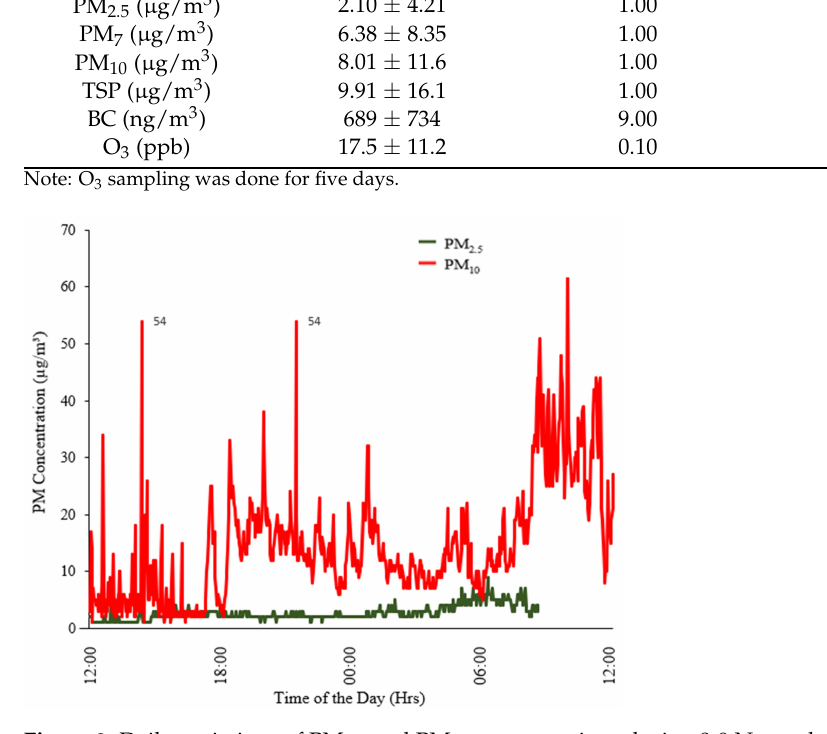
Table 1. Summary statistics of daily average mass concentrations of PM, BC, and O 3 at the Port of Albany, New York, USA during the study period. Pollutant Mean ± SD Min. Max. PM 1 ( µ g/m 3 )